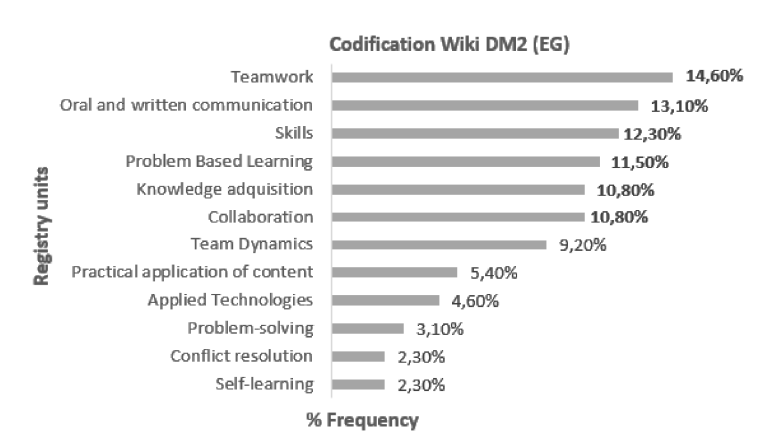
Figure 4. Main results of the frequency analysis of codes reported in the DM2